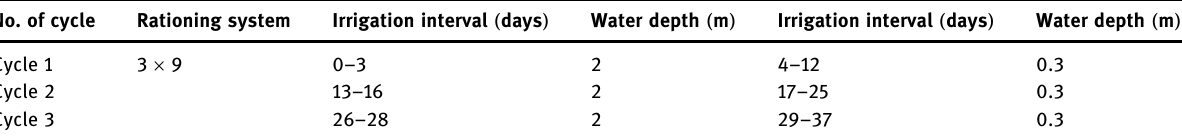
Table 3: The water level in the canal